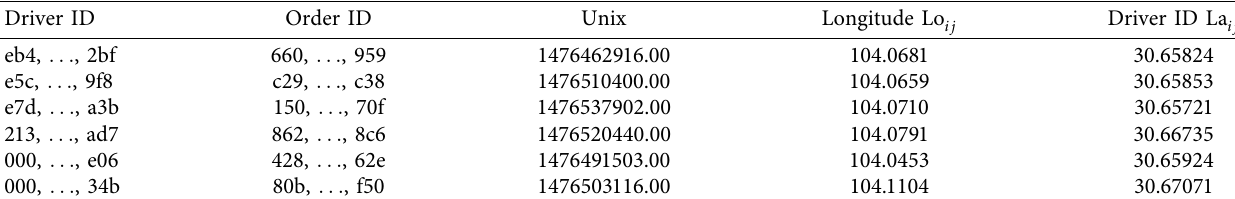
Table 1: Sample of ride-hailing